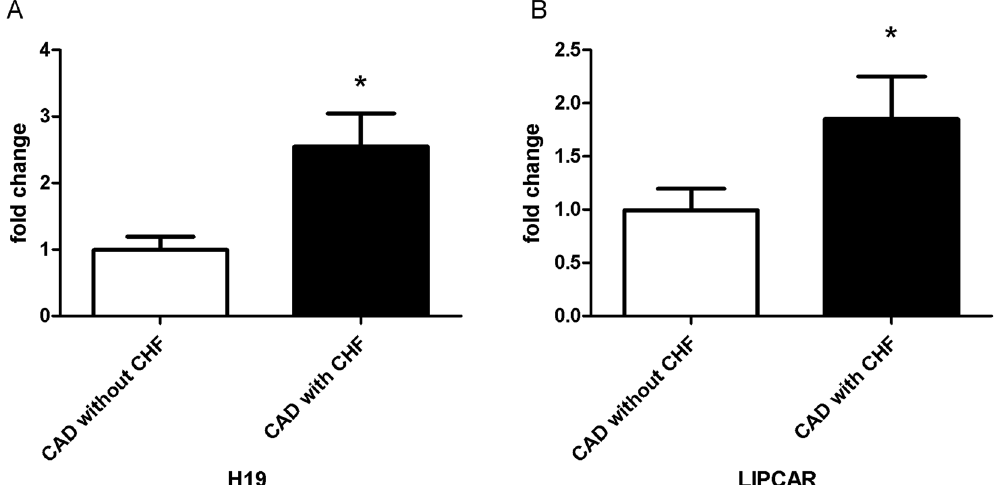
Figure 4. Plasma levels of H19 and LIPCAR in CAD patients with and without CHF. Plasma levels of H19 ( A ) and LIPCAR ( B ) are increased in CAD patients with CHF when compared to those without CHF. CAD, coronary artery disease; CHF, chronic heart failure; * P <